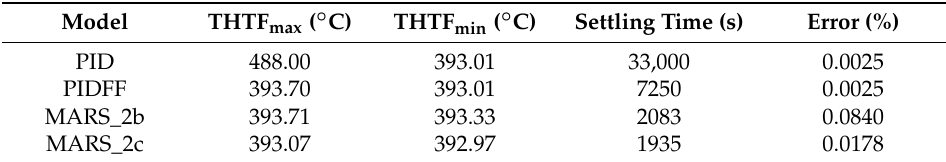
Table 4. Controllers’ response to the sharp step in DNI.